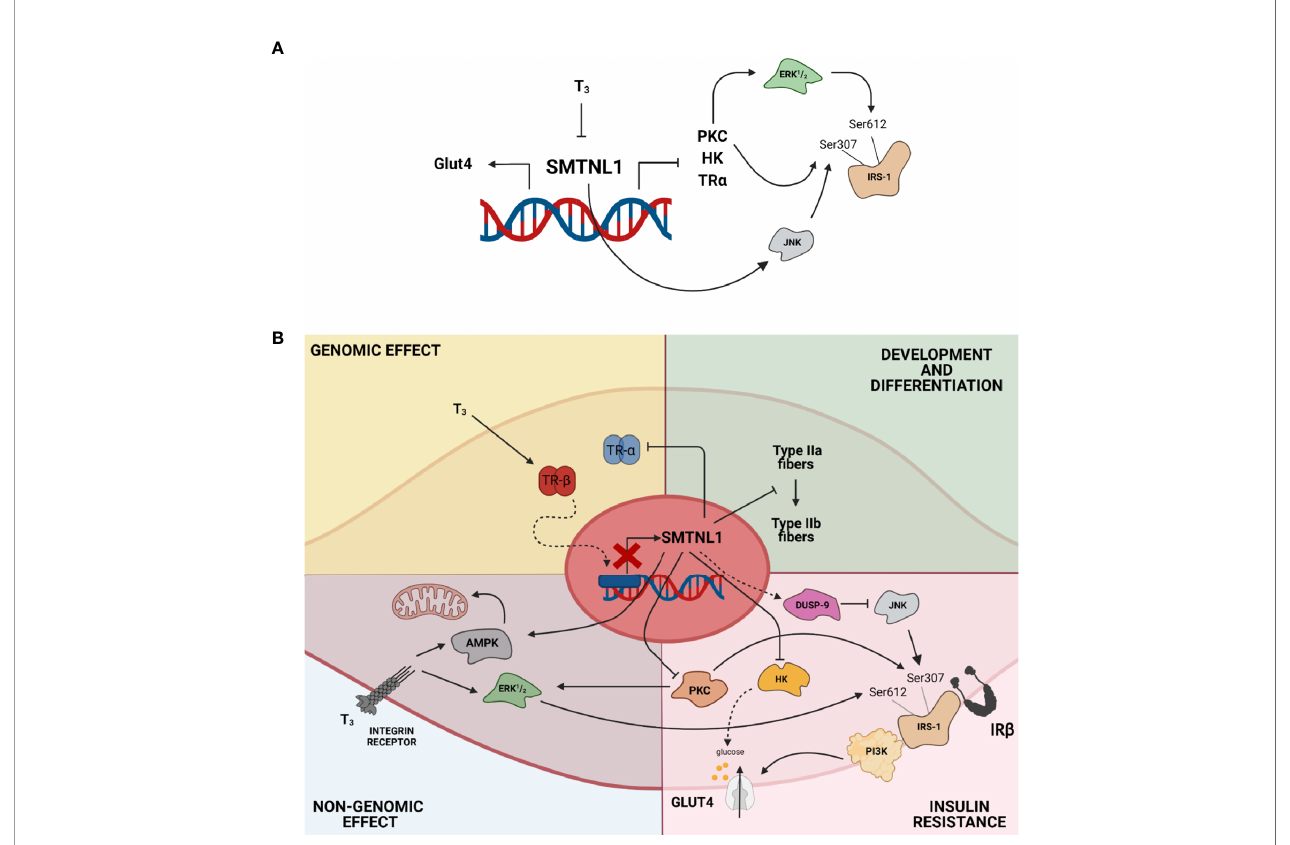
FIGURE 10 | SMTNL1 maintains the homeostasis of SKM in hyperthyroidism. (A, B) SMTNL1 potentially prevents hyperthyroidism-induced changes in SKM via the following mechanisms: 1) SMTNL1 compensates for the glycolytic phenotype shift of SKM triggered by pathological T3 exposure; 2) SMTNL1 induces insulin sensitivity through an insulin-independent heterologous pathway by inhibiting the activity of JNK; 3) SMTNL1 hampers the non-genomic effect of T3 by decreasing the activity of ERK1/2 through PKC d ; 4) SMTNL1 regulates glucose phosphorylation and balances glycolysis and glycogen synthesis by the regulation of HK II; and 5) SMTNL1 selectively inhibits TR a expression, which is a key target of insulin-dependent signaling governed by